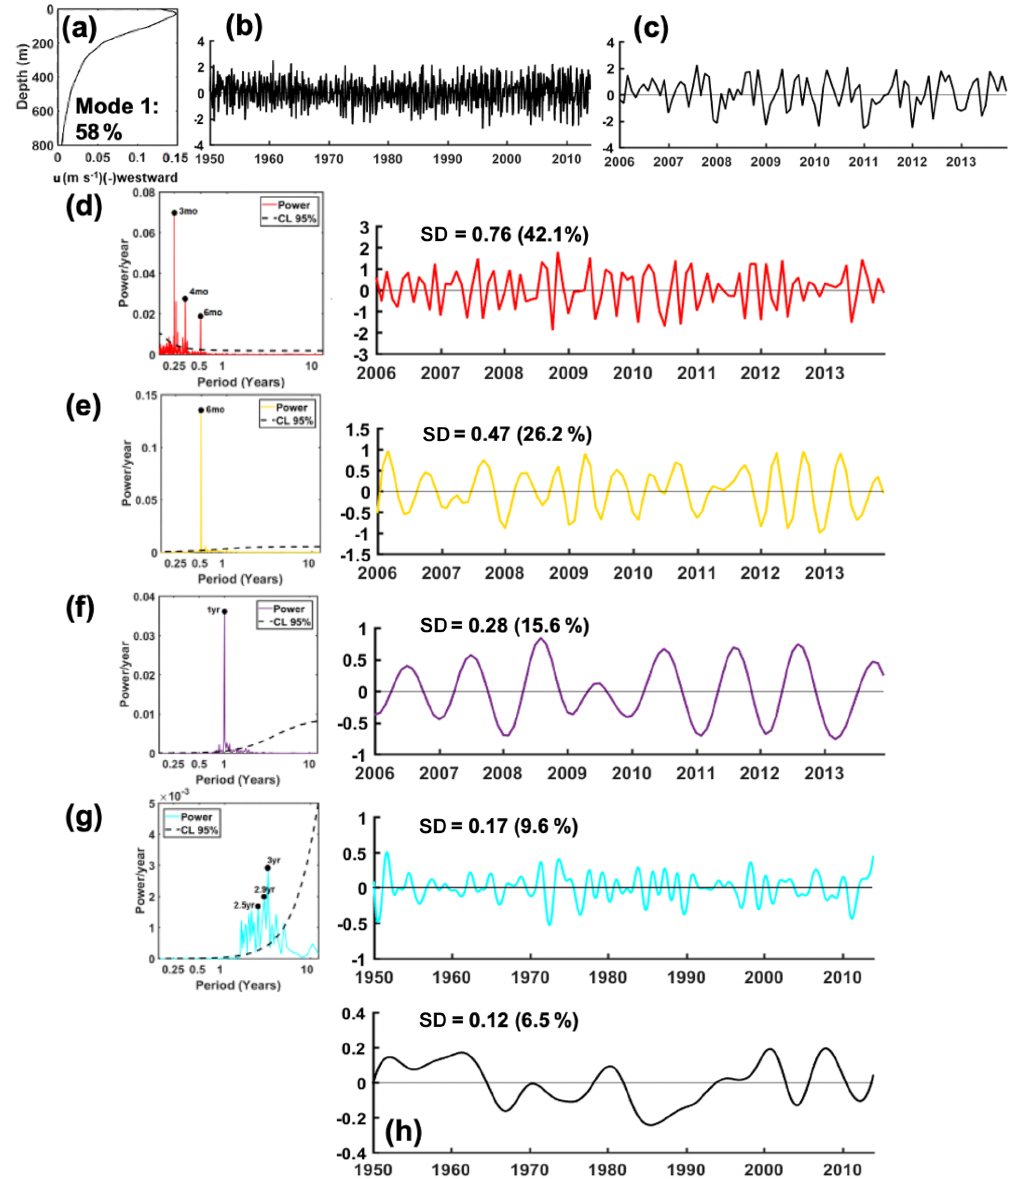
Figure 10. (a) Vertical mode structure and (b) its associated temporal variability of EOF1 (58% of total variance) at the point A WJ . Panel (c) is the same as (b) but only shows the last 8-year period of the EOF1. The EEMD is then applied to the EOF temporal structure to decompose temporal variability: (d) intraseasonal, (e) semiannual, (f) annual, and (g) interannual variabilities with their corresponding red spectrum as a reference for 95% confidence limit (left column), whereas (h) represents the long-term variation and trend. Meanwhile, SD is standard deviation of each EEMD mode relative to the total variance of the